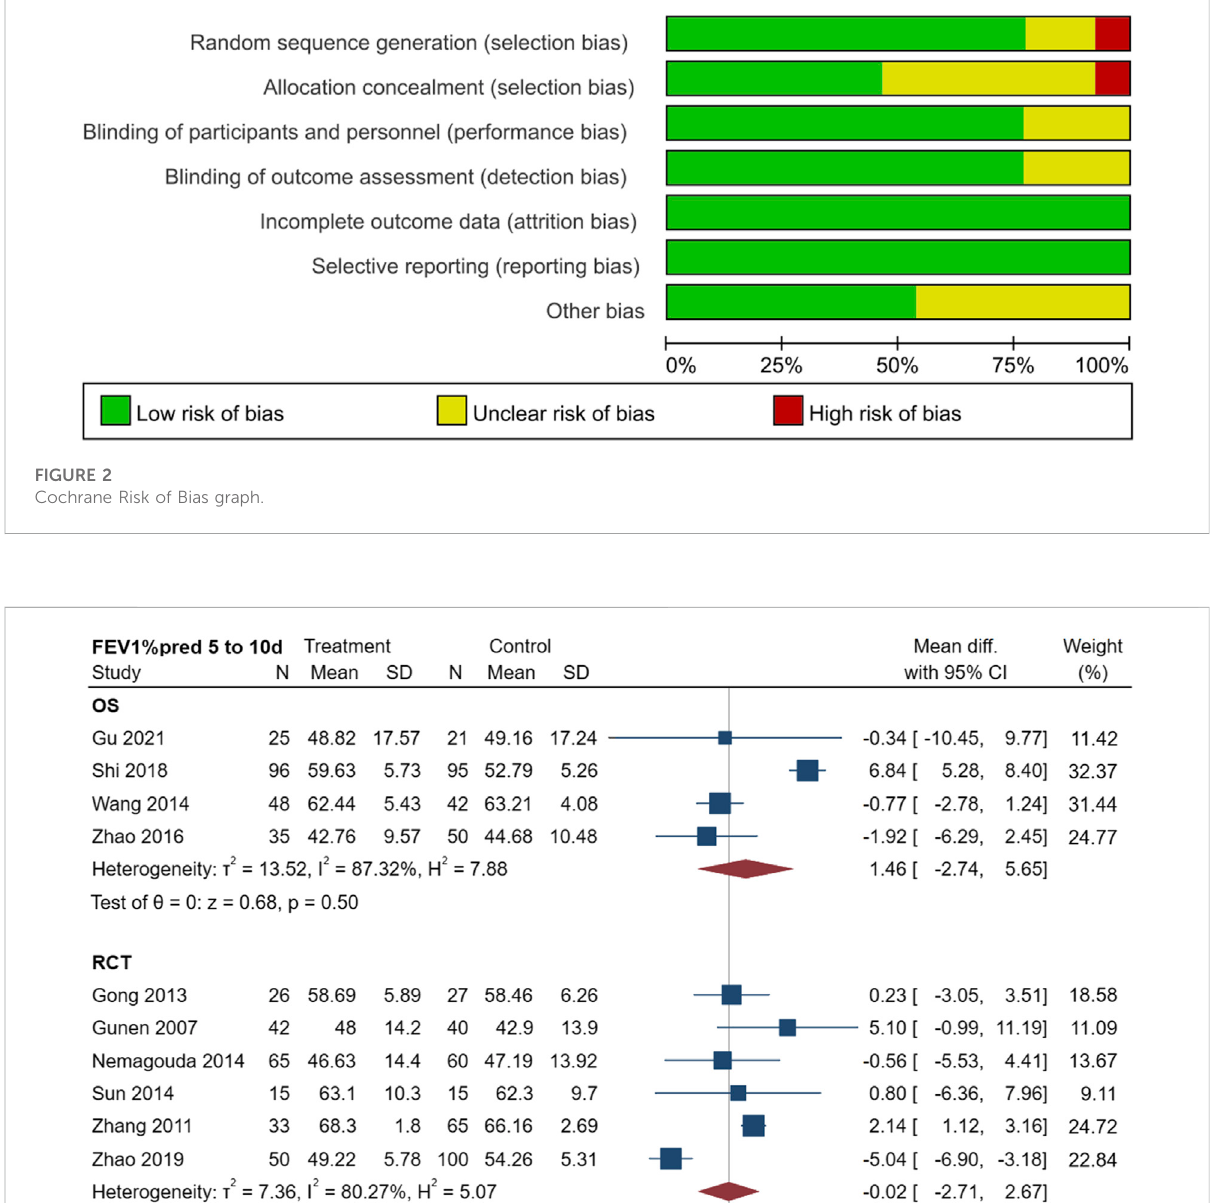
randomized controlled trials or observational studies (e.g., cohort and case-control studies) of the ef fi cacy of NCs compared with SCs for the treatment of AECOPD; patients diagnosed with AECOPD who met Global Initiative for Chronic Obstructive